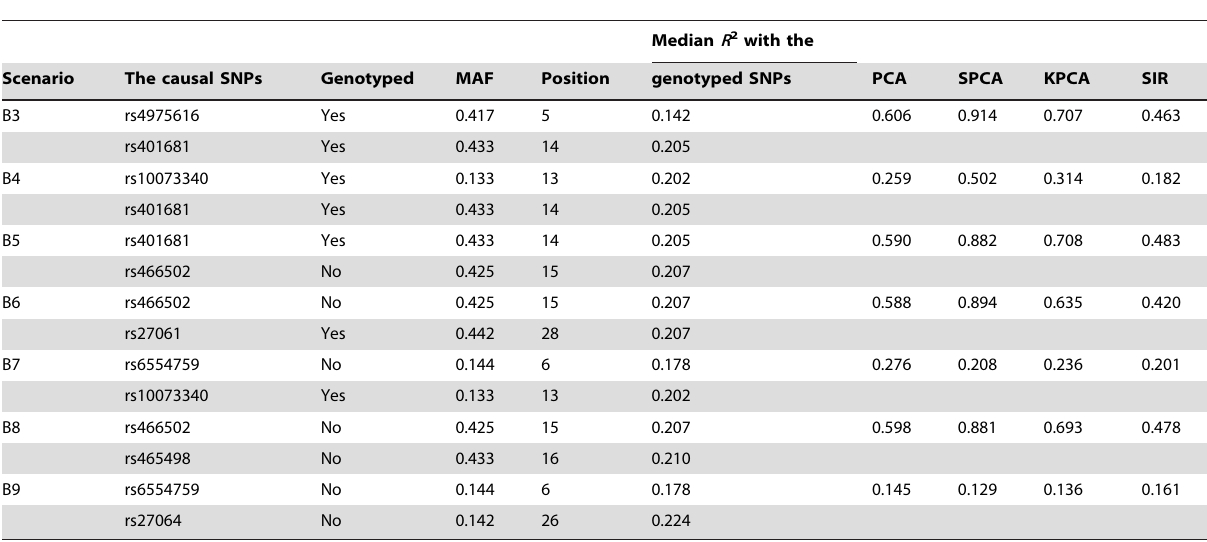
Table 3. Test power at the significance level of 0.05 for four methods in Scenarios B3–B9.